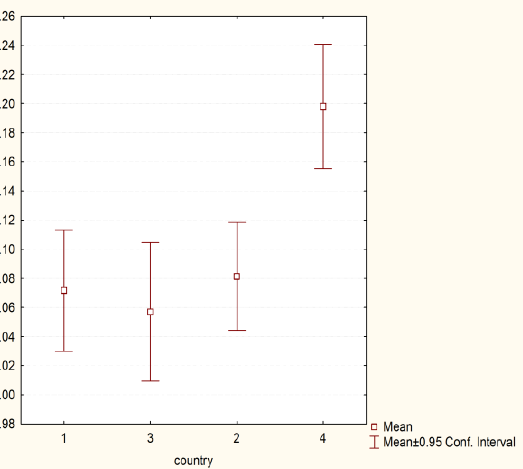
Figure 2. Physical health behaviours and country of origin (H = 22.70252 p = 0.0000). Legend: 1 — Poland, 2 — Hungary, 3 — Greece, 4 — Turkey.